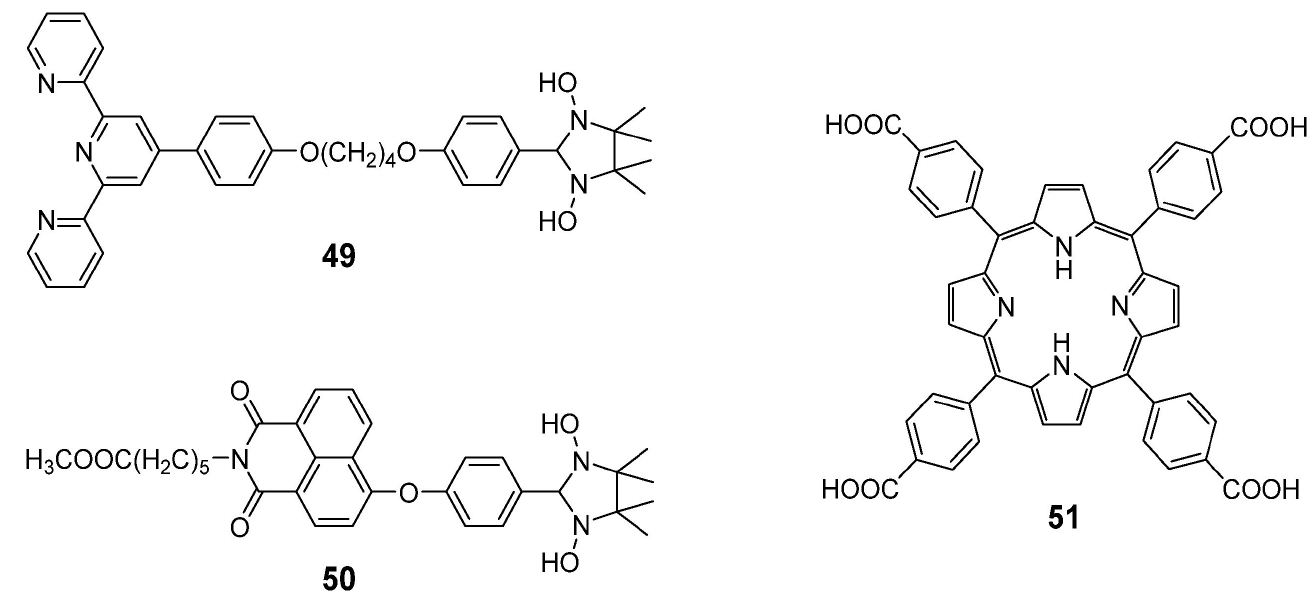
Figure 23. Chemical structures of 49 – 51